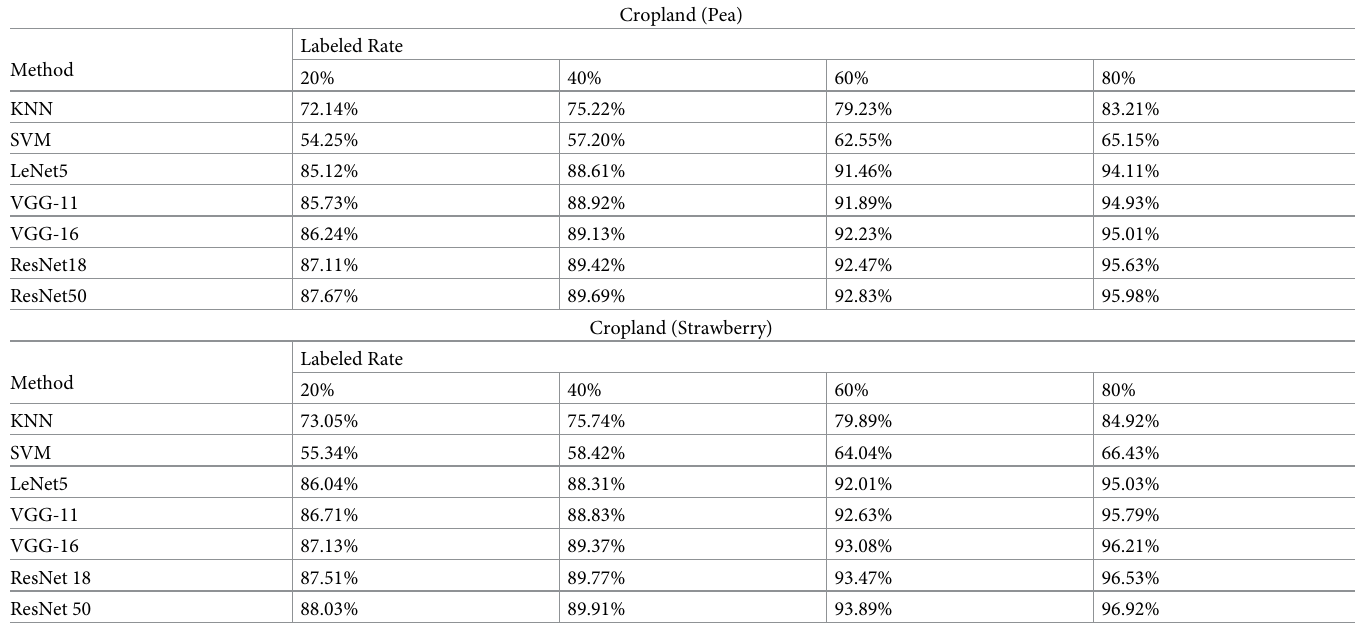
Table 4. Supervised classification accuracy (SCA) of KNN, SVM, LeNet5, VGG-11VGG-16, ResNet18, and ResNet50 on different labeled rates. Cropland